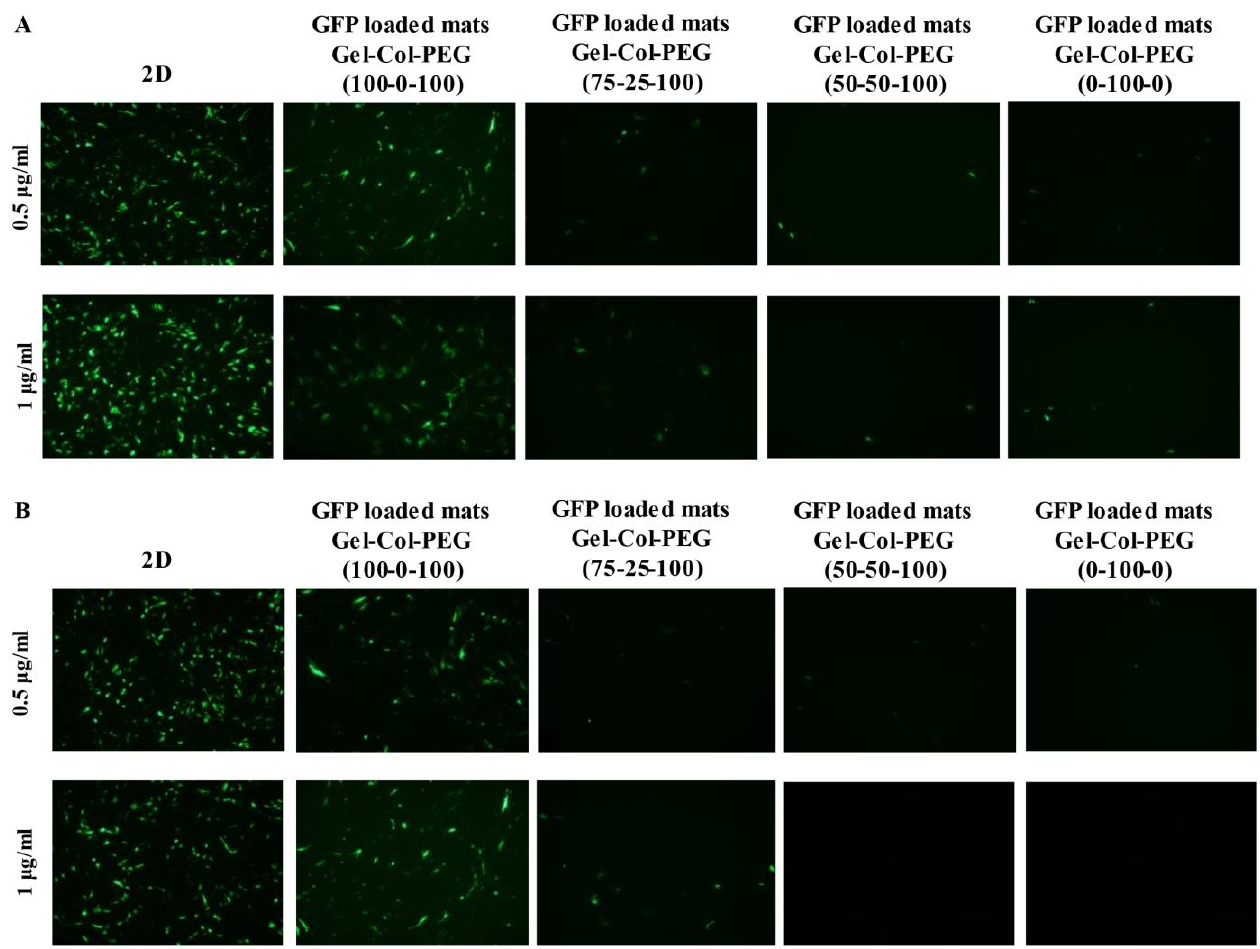
Figure 3. Delivery of gWIZ-GFP complexes via different volume ratio Gelatin-Collagen-PEG mats to C2C12 ( A ) and MC-3T3 ( B ) cells. GFP expression was qualitatively assessed 48 h after transfection using fluorescent microscopy. The percentage of gelatin, collagen and PEG in monolayer mats used is indicated on top of the micrographs where on the left are the pDNA concentrations (1 and 0.5 µ g/mL) in cell culture medium carried by the complexes.